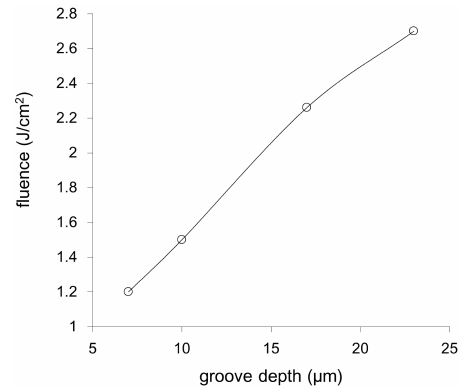
Figure 4. The relationship between the groove depth and laser fluence.